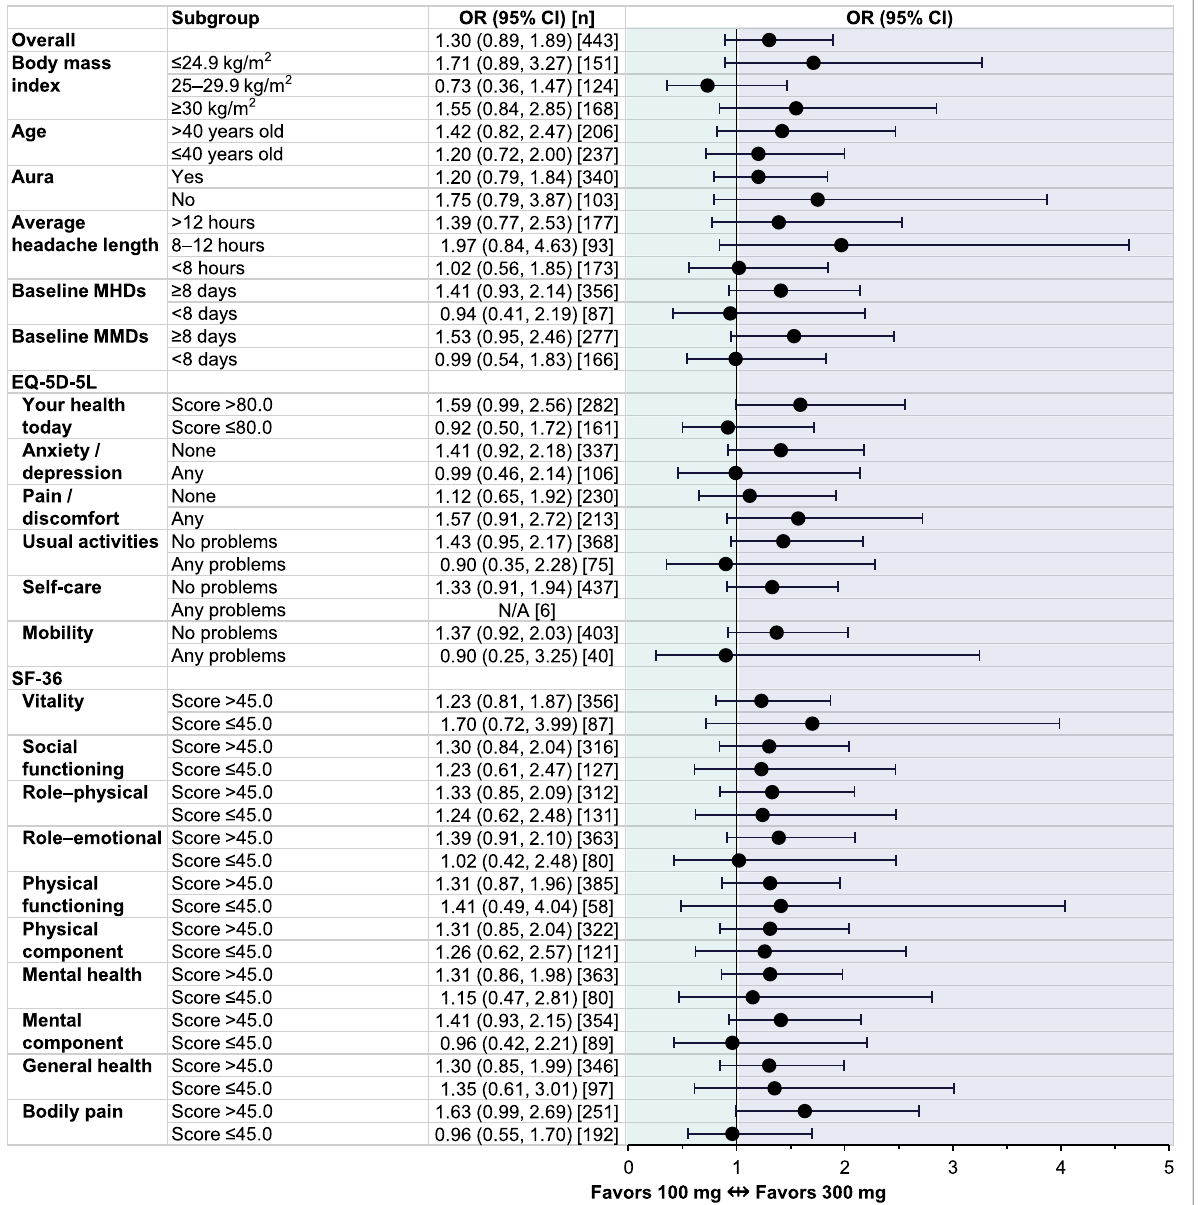
Fig. 1 Odds ratio of 50% MRR over Weeks 1 ‒ 12 in PROMISE-1 subgroups defined by baseline demographics and patient-reported outcome ≥ measures. CI, confidence interval; EQ-5D-5L, EuroQol 5-dimension, 5-level scale; MHDs, monthly headache days; MMDs, monthly migraine days; MRR, migraine responder rate; N/A, not applicable (sample size too small); OR, odds ratio; SF-36, 36-item Short-Form Health Survey